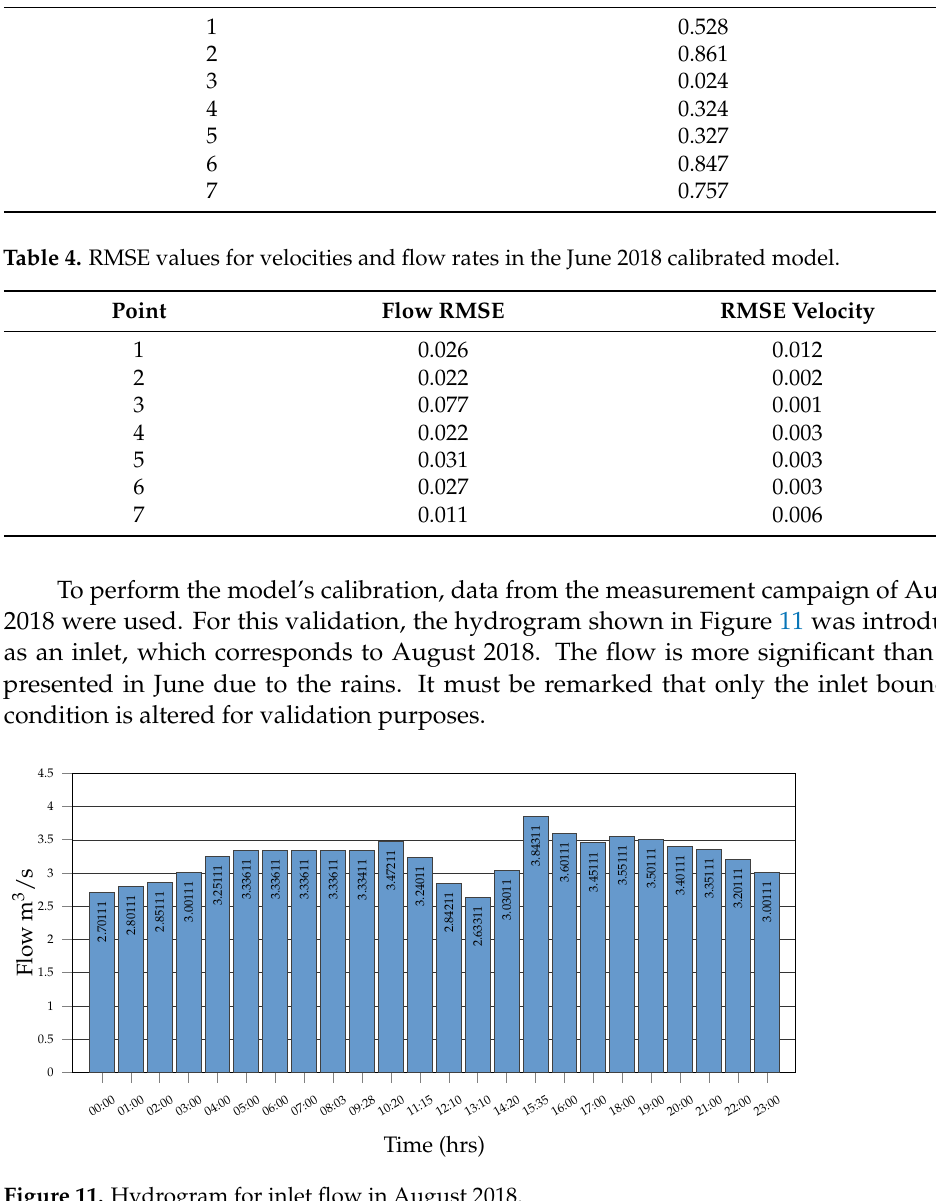
Table 3. RMSE Values for the June 2018 Uncalibrated Model. Point